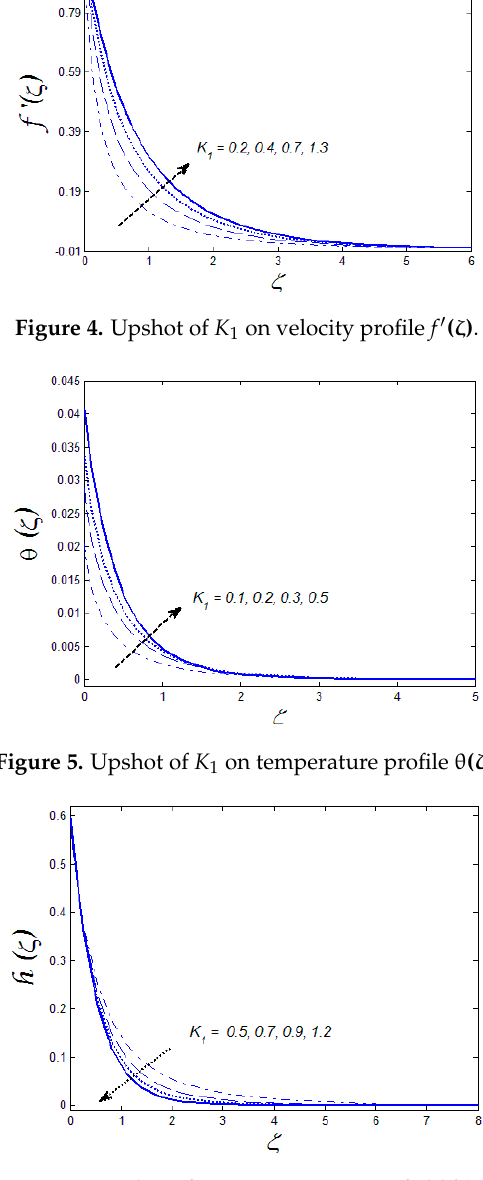
Figure 6. Upshot of K 1 on concentration field h ( ζ ) .